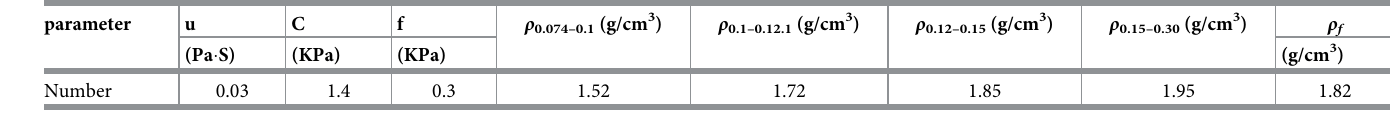
Table 2. Standard configuration of the model calculation